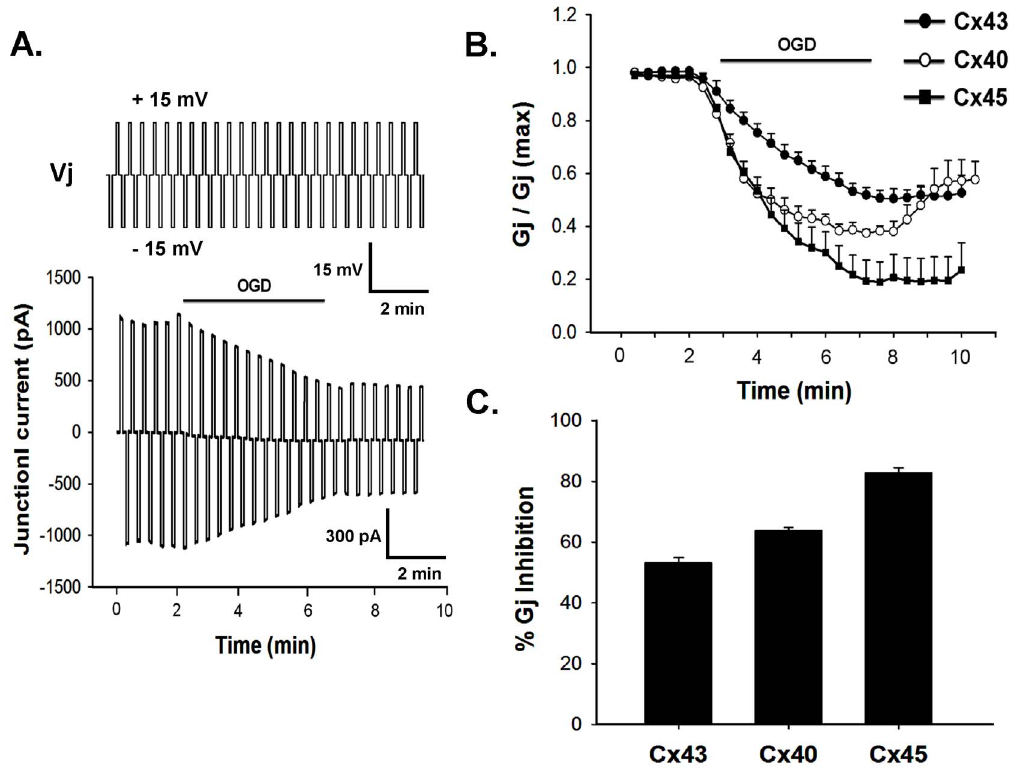
Figure 2. Effect of OGD on different cardiac gap junctions. A . representative I j trace of Cx43 gap junction recorded from transfected N2a cells. I j decreased at the onset of OGD. Solid line above the current trace represents duration of OGD. Voltage protocol is presented on top of the current trace. B . OGD reduced the G j (normalized) of all gap junctions. Cx45 showed maximum reduction. Values are the mean 6 SEM. C . quantitative representation of the data obtained from panel B.